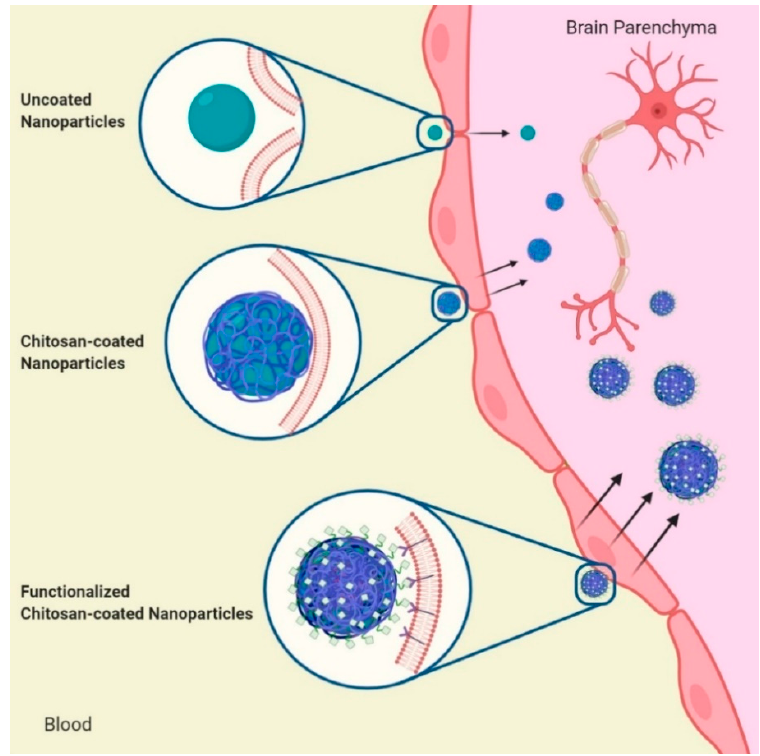
Figure 3. Effect of chitosan coating on nanoparticles to cross the BBB. From top to bottom. Some nanoparticles cross into the brain due to the nanometric particle size. The chitosan coating increases the interaction with the negative charge of the cell membrane in the BBB and increases the passage to the brain. The addition of specific ligands to the chitosan coating favors targeting of nanoparticles and significantly increases the crossing to the